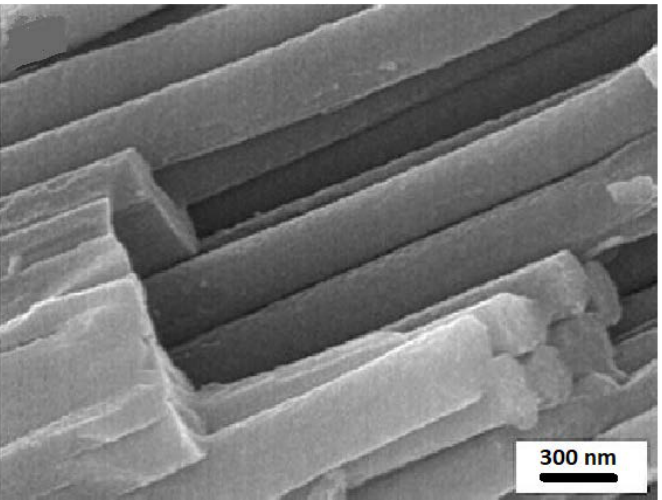
Figure 3. Field emission scanning electron microscopy image of the synthesized TiO 2 nanorod arrays (taken with permission from [79]).